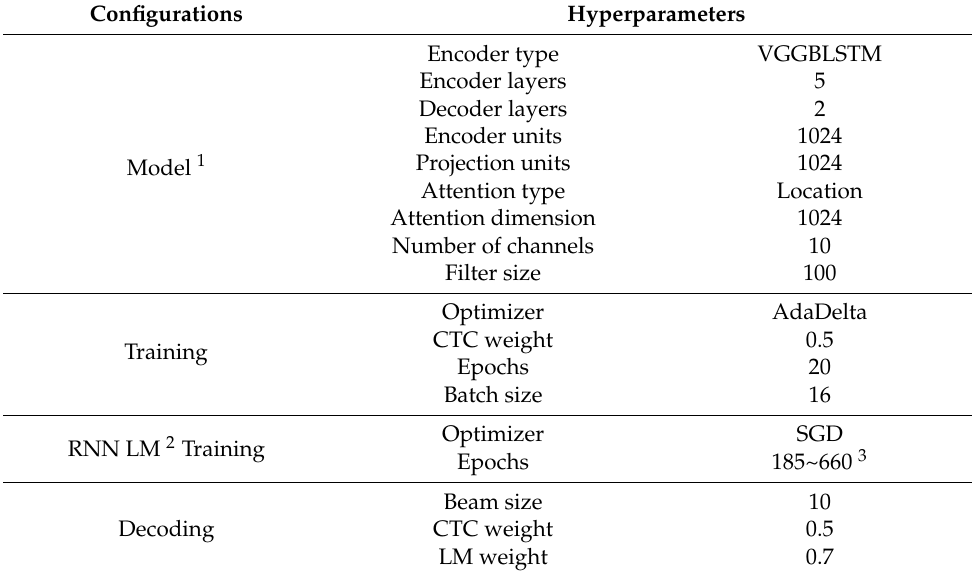
Table 4. The configuration of the experimental setup for the model.